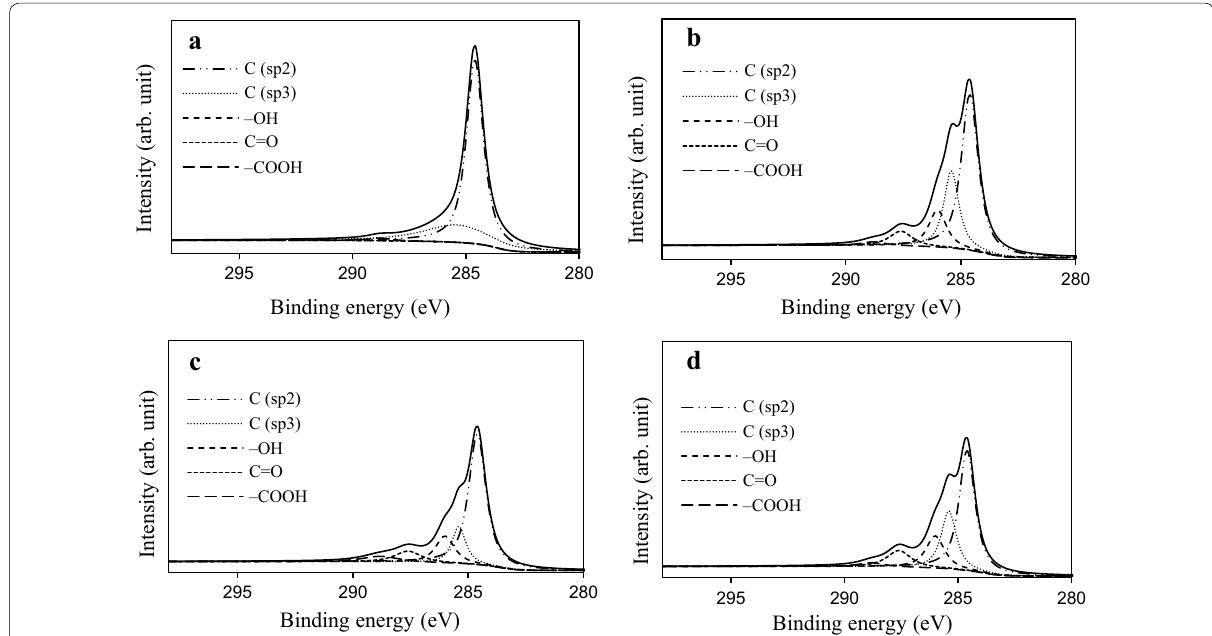
Fig. 5 The high resolution of the deconvoluted XPS C 1s spectra of the ANF samples: a 60-ANF; b 60-ANF-TEPA; c 60-ANF-HNO 3 ; and d 60-ANF-HNO